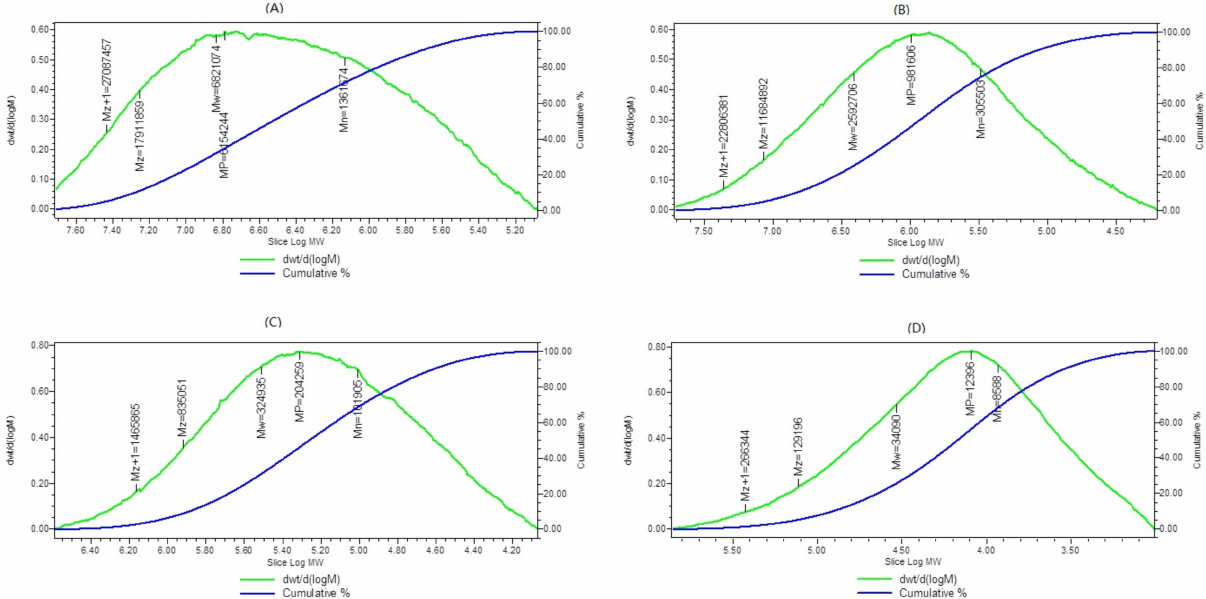
Figure 1. The molar mass distribution of APP and irradiated APP. ( A ) Native APP; ( B ) 10 kGy; ( C ) 100 kGy; ( D ) 1000 kGy. Table 1. The viscosity and average molecular weight of APPs and irradiated APPs. Sample Viscosity